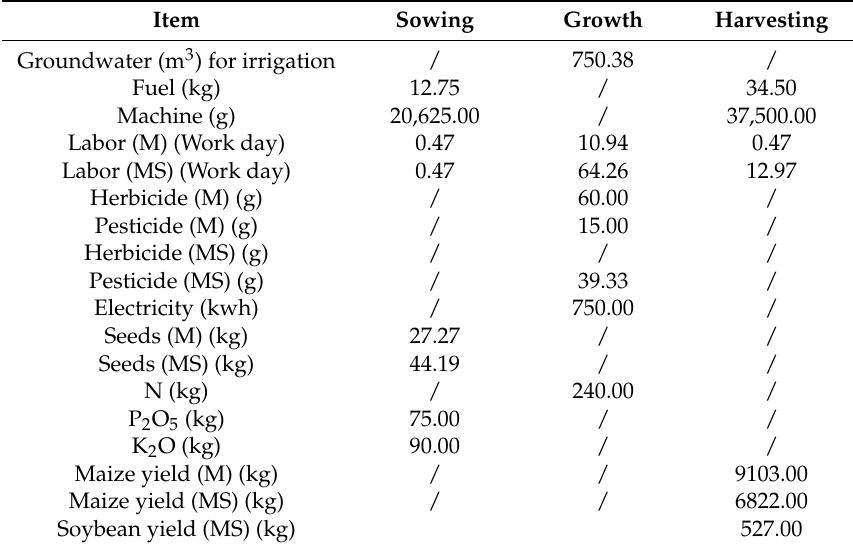
Table 1. The inputs/outputs of the cropping systems (ha − 1